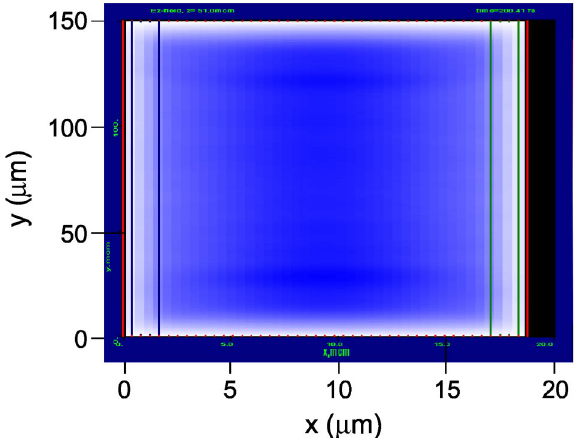
FIG. 2. (Color) Wakefield from a single bunch (located at z (cid:3) 60 (cid:4) m ), moving to the right, shown in the z - x plane at a y -plane location halfway between the top and the bottom. The dielectric boundaries are the horizontal lines at x (cid:3) 1 : 9 and 16 : 9 (cid:4) m . The color scale on the right is proportional to the field intensity, and the maximum is (cid:4) 40 MV = m in magnitude. Note the diffuse region for z < 30 (cid:4) m due to the interference of the wakefield and transition